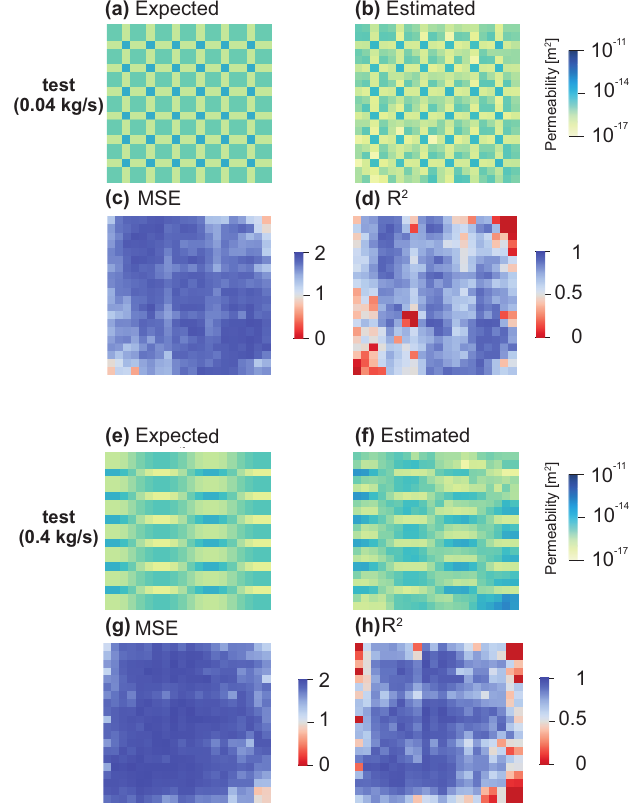
Figure 7. Estimation accuracy in the case of different mass flow rates at the source from the training data. ( a ) Expected vs. ( b ) estimated values, and spatial distributions of ( c ) MSE and ( d ) R 2 for the mass flow rate of 0.04 kg/s. ( e ) Expected vs. ( f ) estimated values, and spatial distributions of ( g ) MSE and ( h ) R 2 for the mass flow rate of 0.4 kg/s.